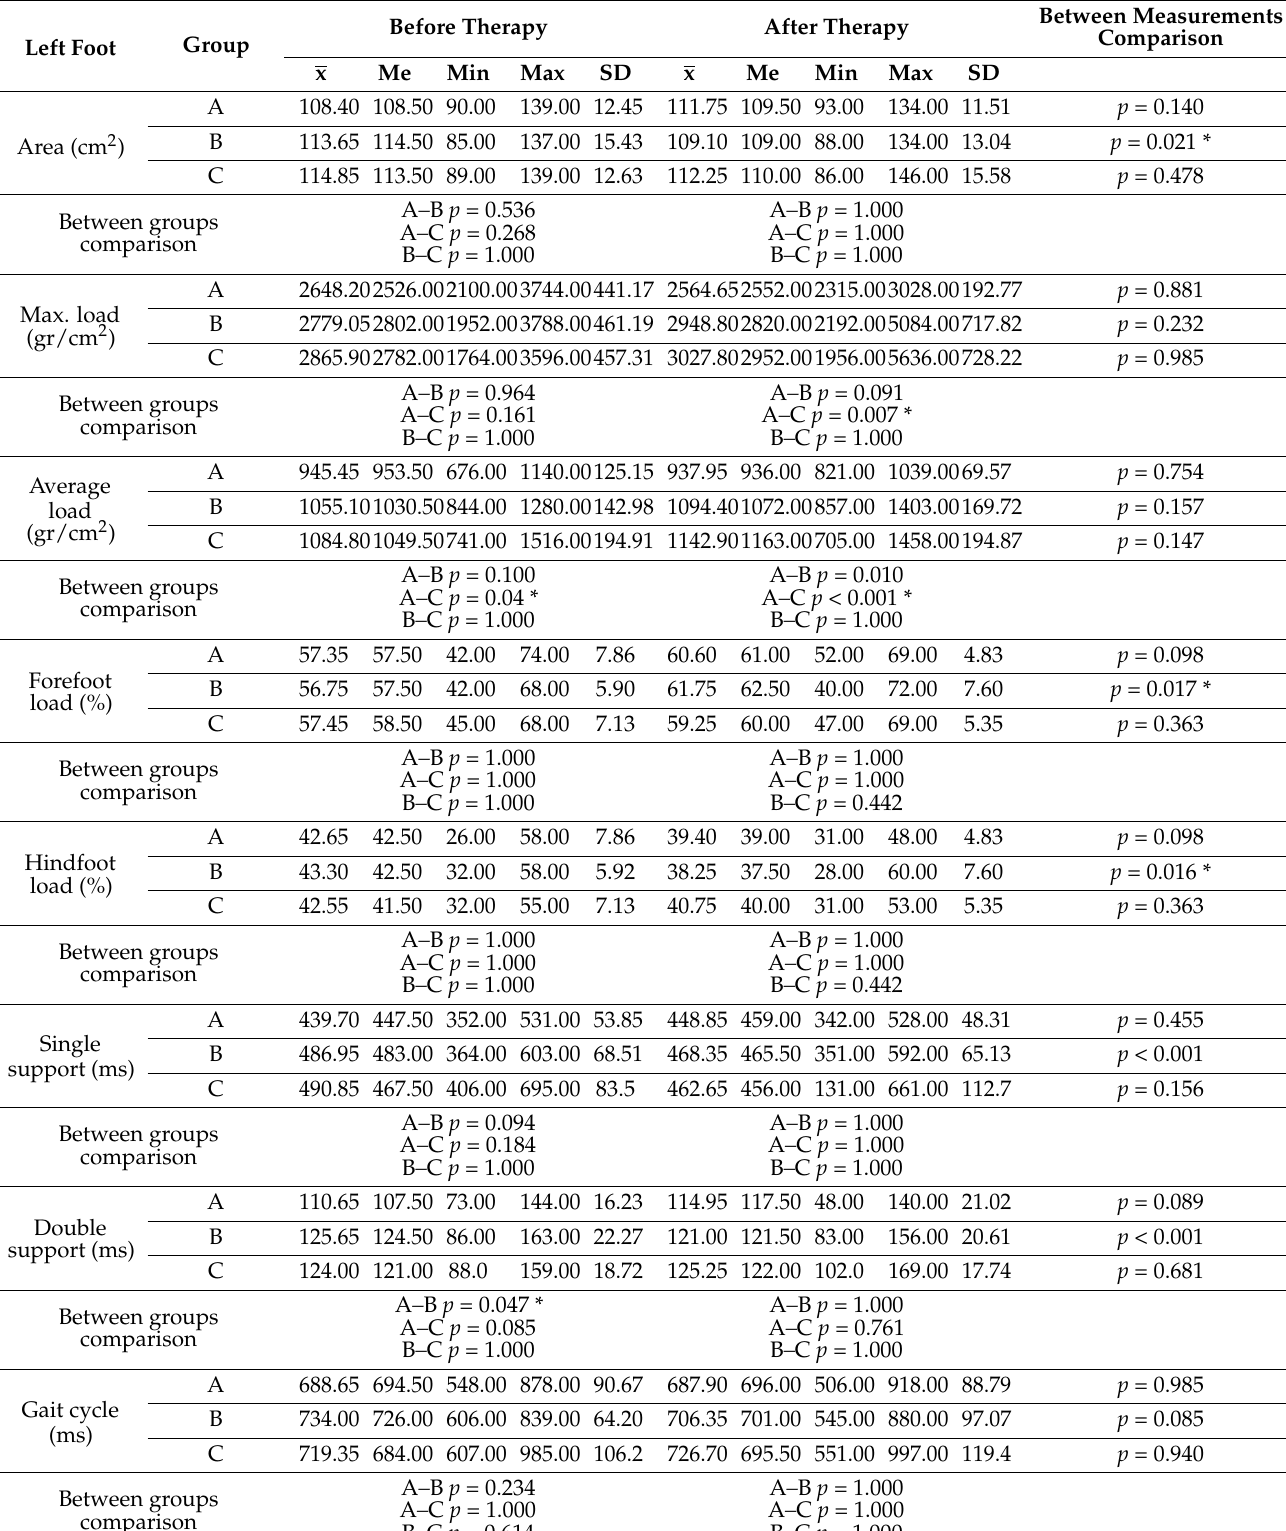
Table 4. Differences between selected left foot dynamic indicators in individual groups before and after